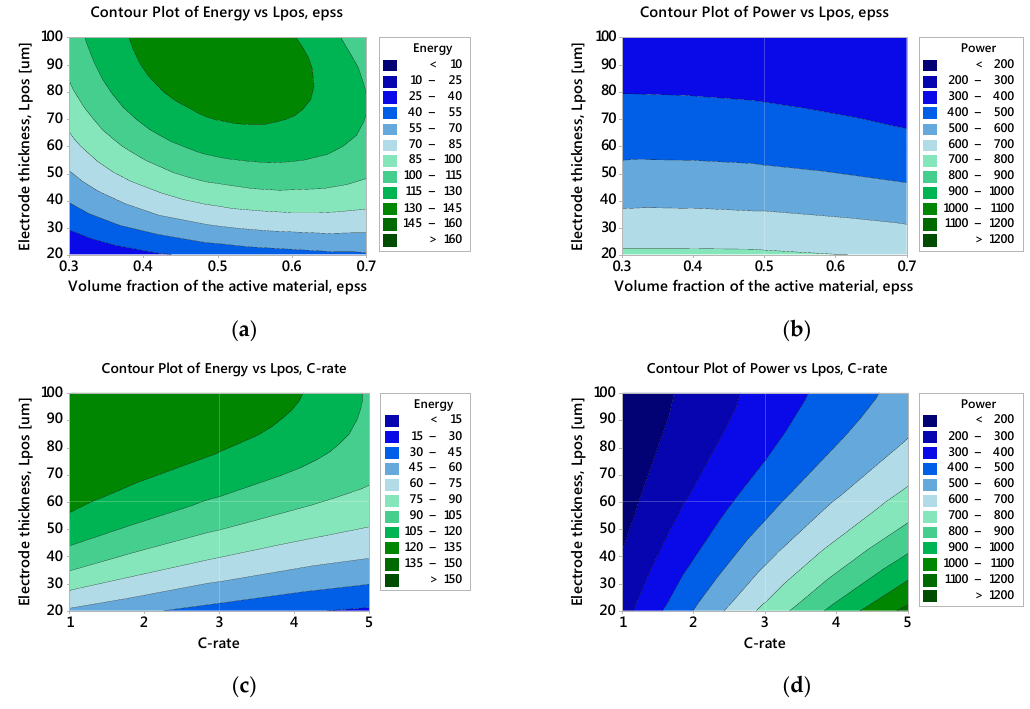
Figure 9. Contour plot of: ( a ) the specific energy as a function of ( L pos , ε s , pos ); ( b ) the specific power as a function of ( L pos , C-rate); ( c ) the specific energy as a function of ( L pos , ε s , pos ); ( d ) the specific power as a function of ( L pos ,